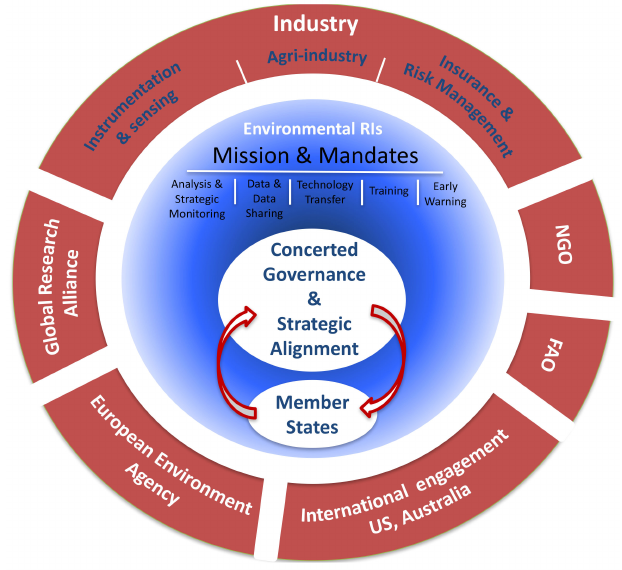
Figure 2. A conceptual diagram that outlines the need to internally align the governance and the directives of sponsors (in this case, the member states) to further optimize and add value to other external needs and economies, e.g., industry, non-governmental organizations, the United Nations Food and Agriculture Organization, and the like. This example highlights the external agronomic needs and